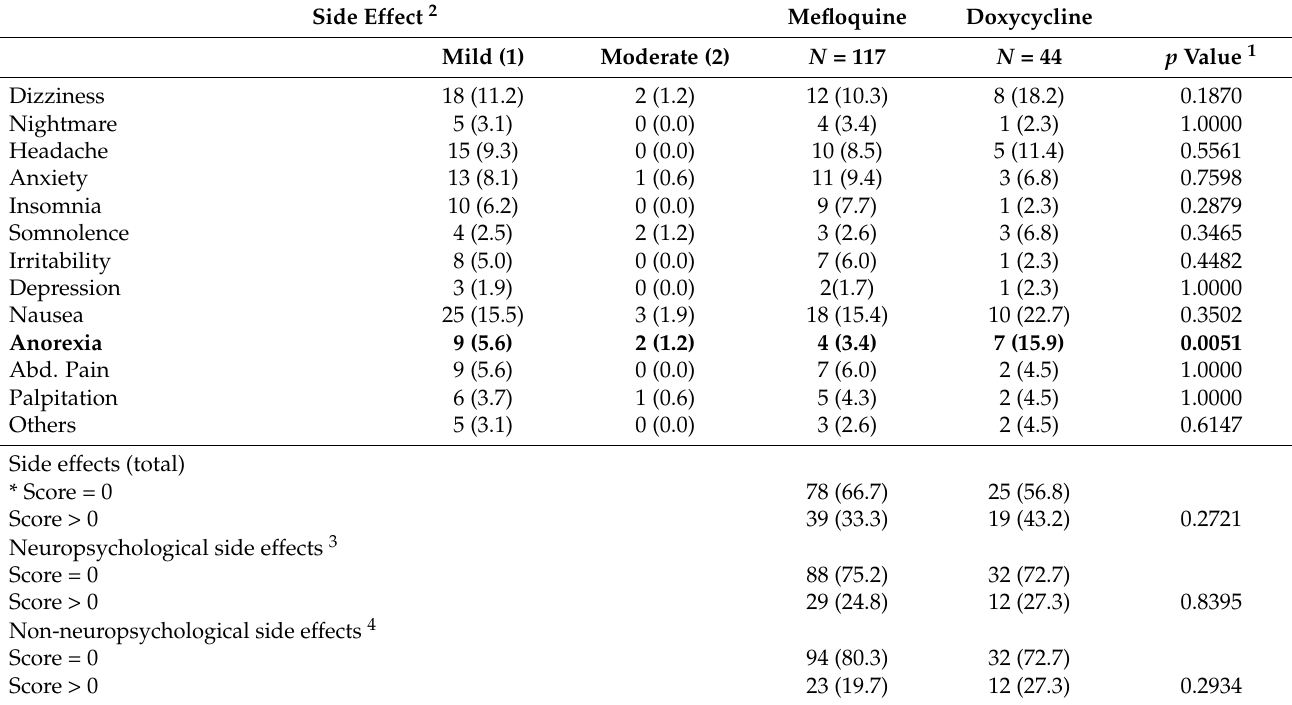
Table 2. Associations between side effects and antimalarial drugs. N =